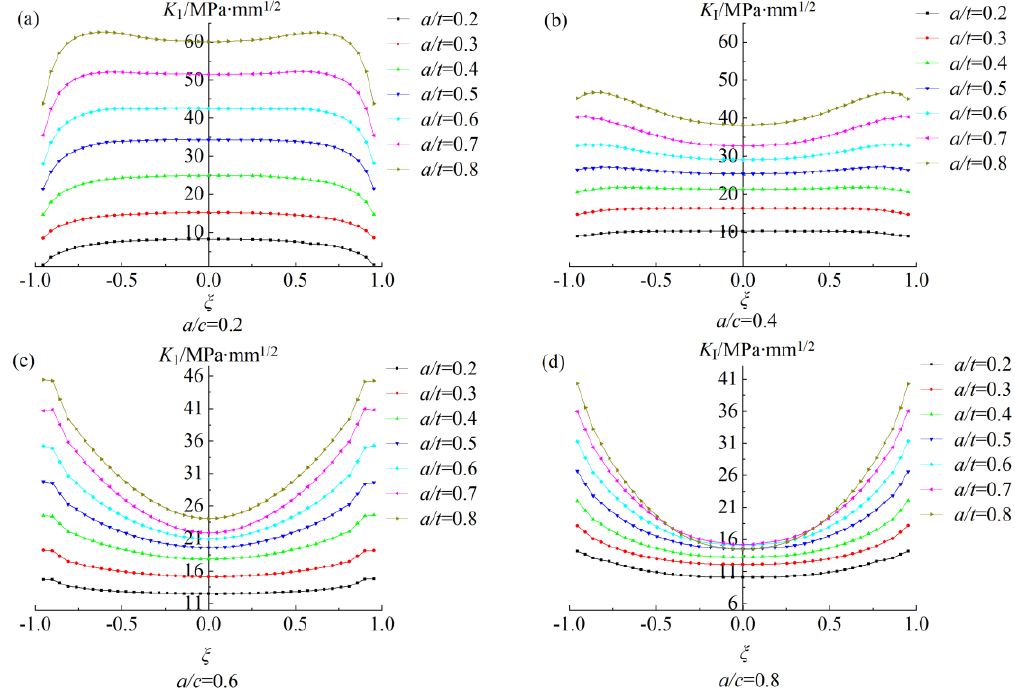
Figure 6. Distribution of type I SIF ( K I ) at the front of semi-elliptical crack on the neck of the ampoule bottle. ( a ) a / c = 0.2. ( b ) a / c = 0.4. ( c ) a / c = 0.6. ( d ) a / c = 0.8.